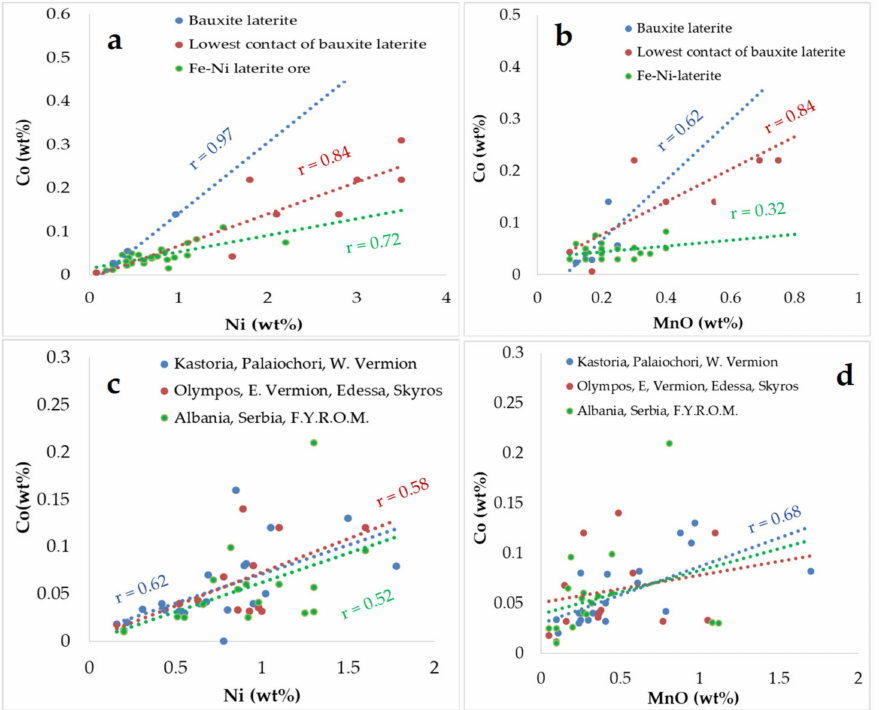
Figure 8. Plots of Co versus Ni and MnO from the Lokris ( a , b ), and other Fe–Ni laterite deposits from Greece, Albania, Serbia, and N. Macedonia, former F.Y.R.O.M. ( c , d ), revealed the pronounced positive correlation between Co and Ni, Mn at the lowest parts of the Lokris deposit, near the contact with the carbonate basement. Data from Tables 2–5.